Question: Author a descriptive caption for the visualization shown.
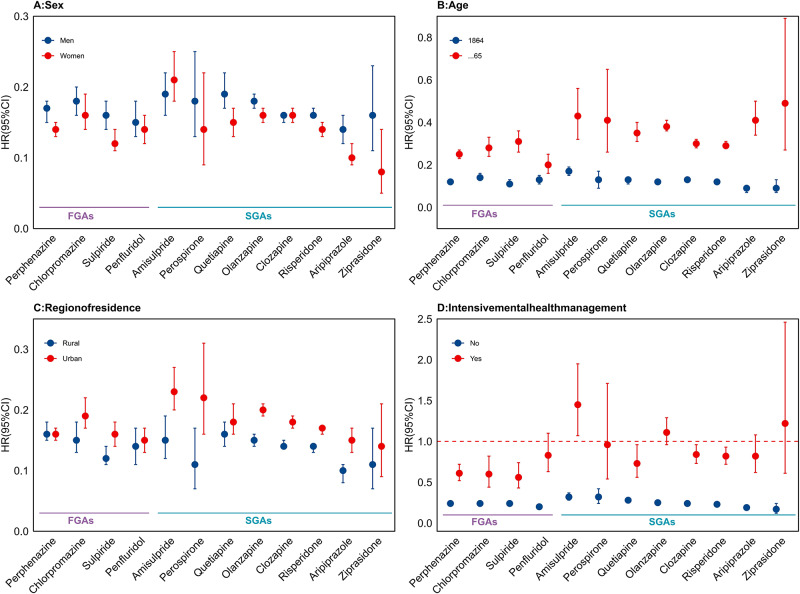
Answer: Stratified analyses of the associations between antipsychotic prescription and mortality risk among schizophrenia patients receiving monotherapy. Hazard ratios (HRs) and corresponding 95% confidence intervals (CIs) for all-cause mortality associated with antipsychotic treatments were calculated using a Cox proportional hazards model with the non-drug group as the reference category. HRs were adjusted for demographic characteristics, comorbid conditions, severity of schizophrenia and intensive mental health management. Analyses are stratified by (a) sex (men vs. women), (b) region of residence (urban vs. rural), (c) age group (<65 vs. ≥65 years) and (d) intensive mental health management (yes vs. no). Figure 2 long description.